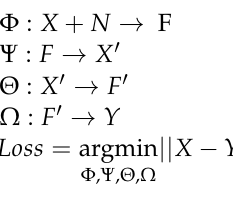
Figure 4. The neural architecture of the dual autoencoder. As shown in Figures 3 and 4, the number of kernels in the last layer gives the ability of this model of autoencoder to denoise colored images or gray images. In our experiment, we used a transpose convolution layer with 100 × 100 × 1; therefore, the denoise process is on gray scale images. However, when changing the parameters in the last layer to three kernels instead of one, the same model will be able to denoise colored images. The noisy image of size 100 × 100 × 1 is the input of the autoencoder illustrated in orange. Then, the encoding presented in blue takes place by reducing the input size 100 × 100 to 23 × 23. The encoder marked in blue comprises three layers, and every of them is a separable convolu- tional neural network. These networks have filters 3 × 3 × 50, 3 × 3 × 35, and 3 × 3 × 25 with 50, 35, and 25 kernels, correspondingly. Then, the decoding process is shown in green; this process raises the output of each layer to reach the 100 × 100 × 1 image similar to the input one but with noise reduction. Like Figure 2, the autoencoder in Figure 3 is added to an- other autoencoder with the same architecture but with the softer size decreased to enhance and denoise. The encoding process is described in Equations (7–10), whereas the decoding process is described in Equations (11–14) for using both convolutional and separable con- volutional neural networks. The purpose of building the autoencoder and dual autoen- coder using separable convolutional neural networks and convolutional neural networks is to compare between the performance of the two types of neural network knowing that separable convolutional neural networks achieve a convolution product with a smaller number of learnable parameters. The capability of the convolution layer to extract data with local characteristics is directly connected to the complexity of this layer. Because of its consistent structure, it is more analogous to the neural networks seen in the human brain. It also makes the model easier to understand because it reduces the total number of weights. Padding is added to the input matrix right before the product is finished so that it can accommodate all of the inputs. Padding parameters can have two values, zero or one. The primary use of the padding parameter is to resolve how many elements to add to the original image or matrix to increase its size in a way that makes all its pixels